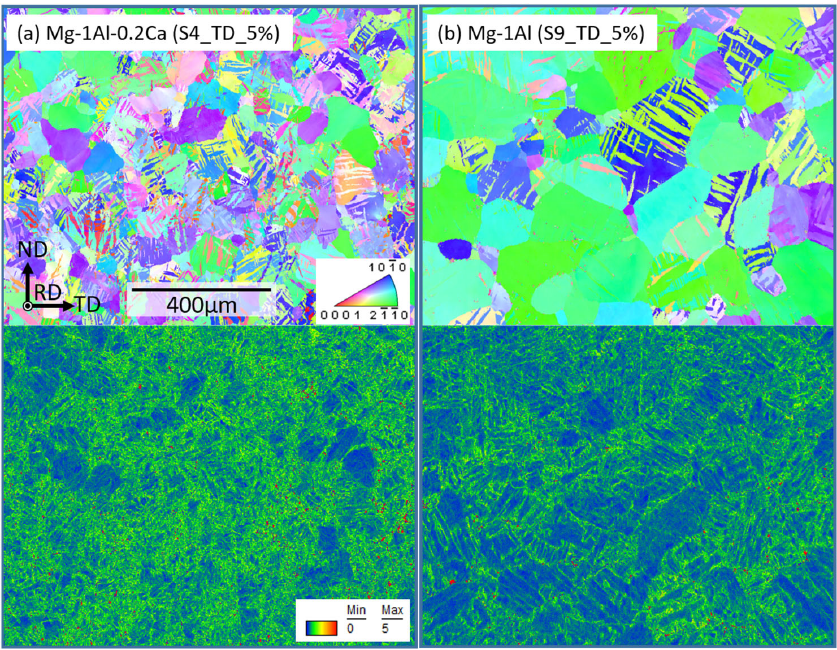
Figure 11. ( a ) S4_TD_5%: Top: IPF map. Bottom: KAM map. ( b ) S9_TD_5%: Top: IPF map. Bottom: KAM map.